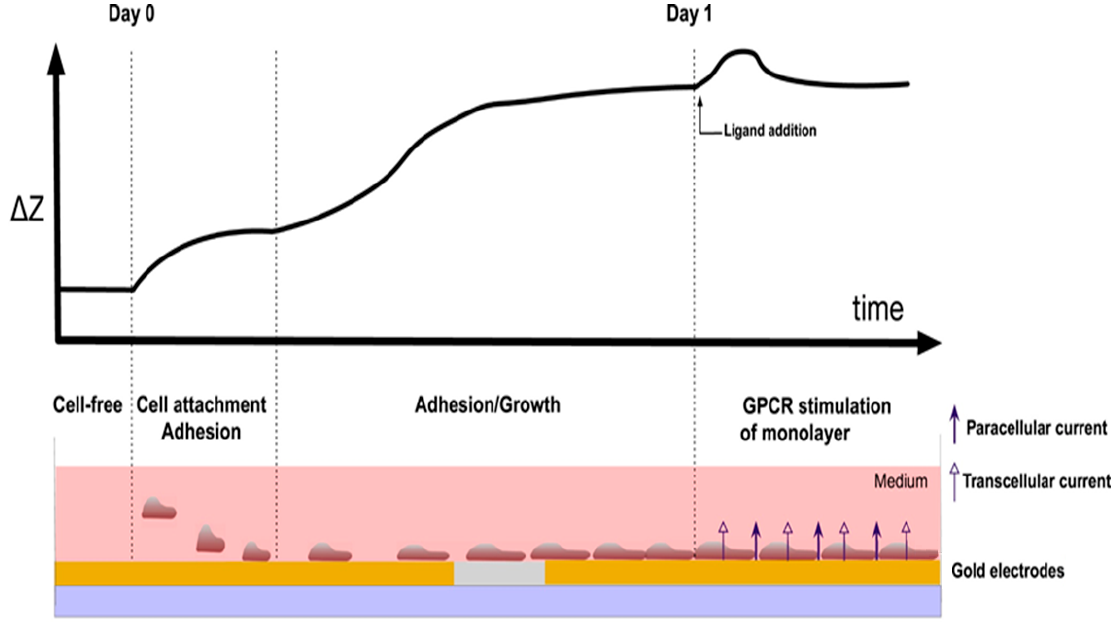
Figure 2. Illustration for the CBI-based assay for the detection of cell adhesion and growth. Once a monolayer of cells was formed, subsequent toxicology and drug screening experiments could be performed. Adapted from Doijen et al. with permission from Elsevier [30].